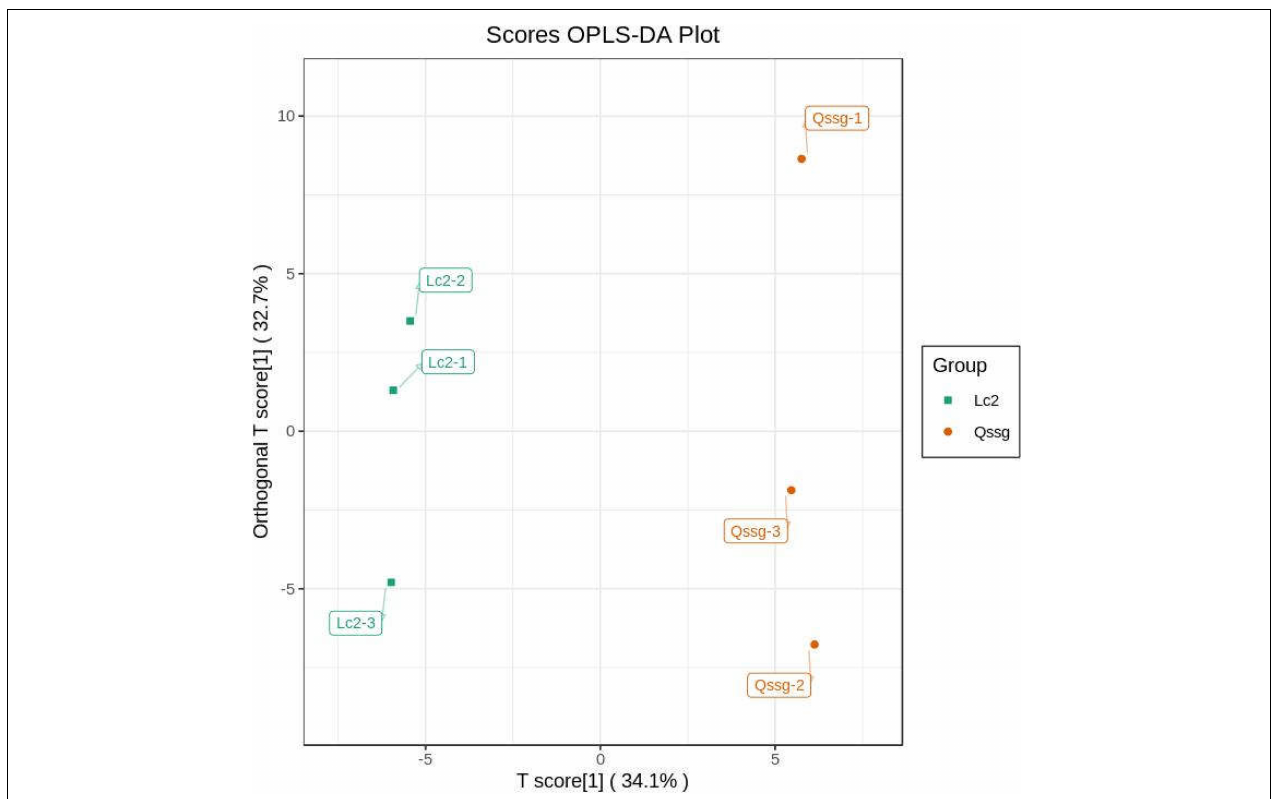
FIGURE 4 | Orthogonal partial least squares discriminant analysis score map of metabolites in Qssg and Lc fruits. Each point represents an independent biological